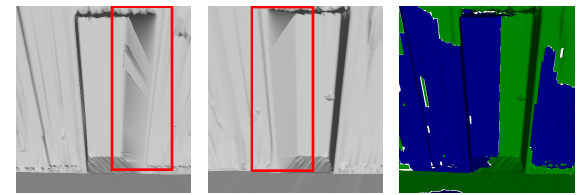
Figure 12. An example of mesh stitching. The left mesh is in , right mesh is in , and the added triangles are in . ing from triangle selection are filled by triangles. As shown in Figure 12, the triangles in magenta are added to fill the